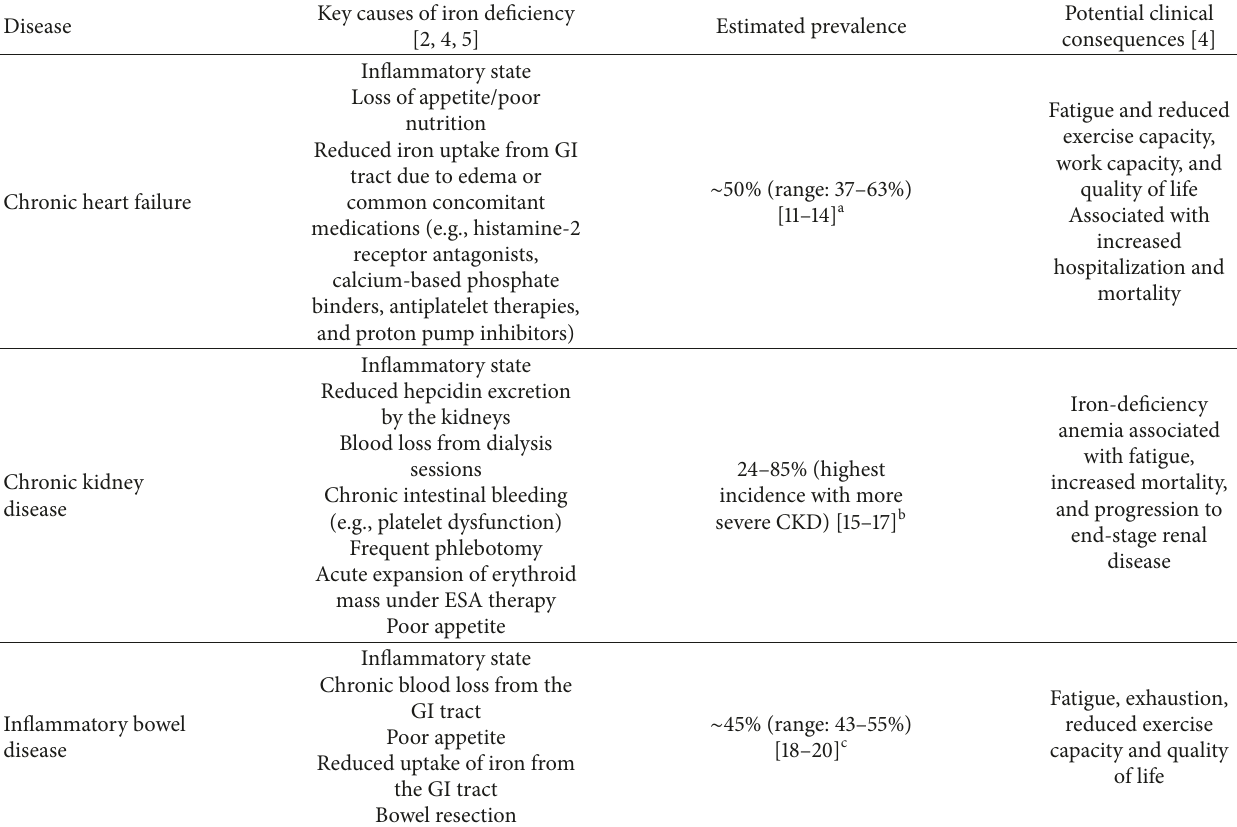
Table 1: Causes, prevalence, and clinical consequences of iron deficiency in inflammatory conditions.